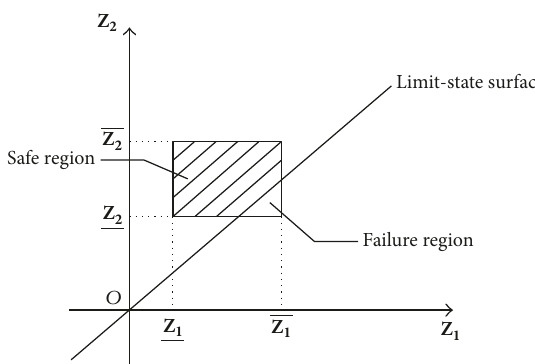
Figure 1: Scheme for safe region and failure region.